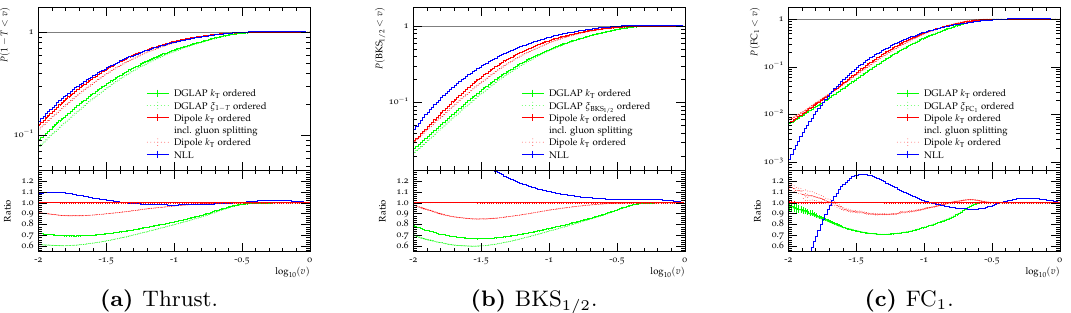
Figure 7 . Comparison between plain DGLAP parton shower ordered in (cid:24) to DGLAP parton shower ordered in dipole- k T and dipole shower with and without gluon